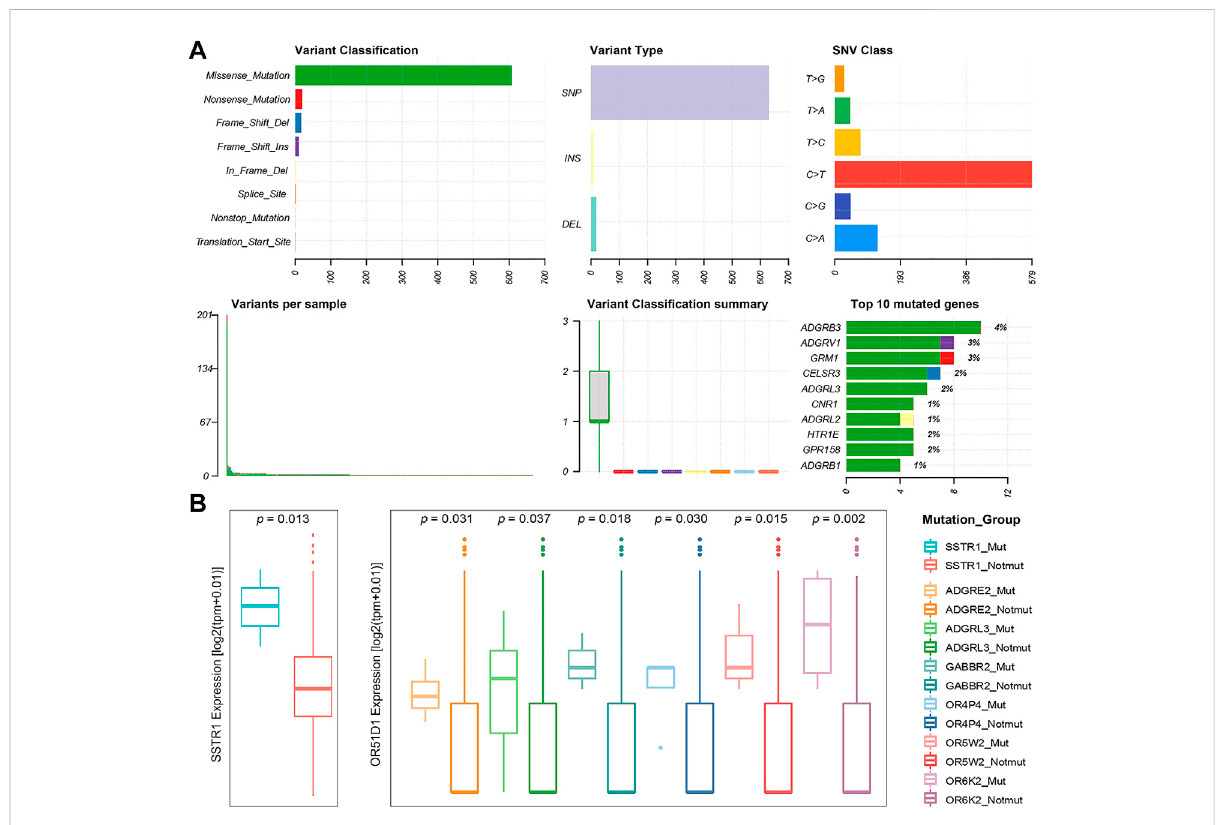
FIGURE 2 StatisticsofGPCR Mutations. (A) AlandscapeoftheGPCRsmutatedin276primary prostate tumor samplesgenerated byMaftools visualization module. (B) Boxplotsoftheexpression levelsof SSTR1 (left)betweenthe SSTR1 mutatedand unmutatedgroups,and OR51D1 (right),an example ofa gene that is dysregulated between the mutated and unmutated tumor samples of the other